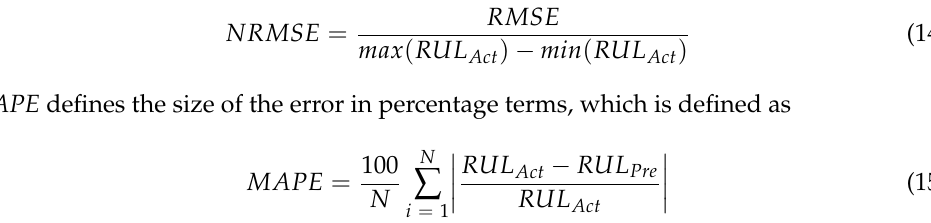
metrics are calculated, including α − λ , root mean square error ( RMSE ), normalized root mean square error ( NRMSE ), mean absolute percentage error ( MAPE ), and fitness degree R 2